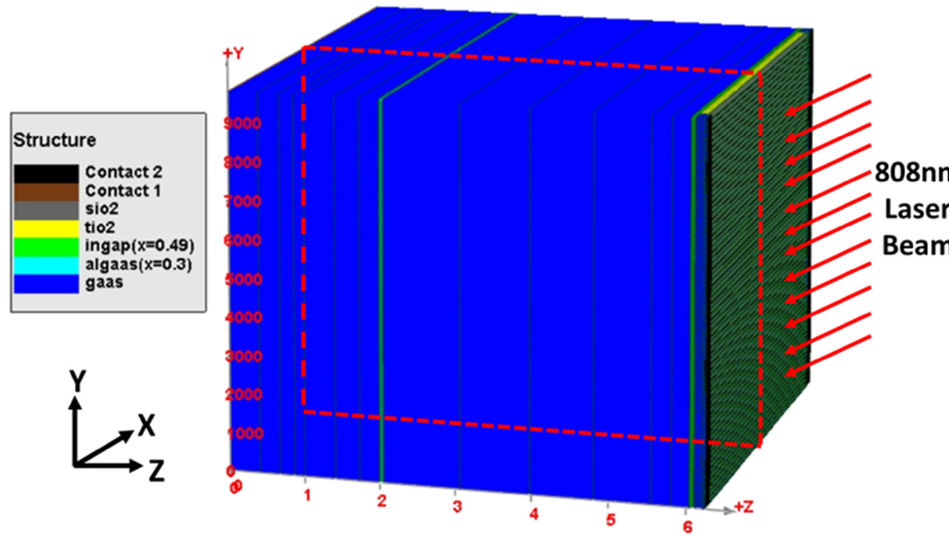
Figure 9. The cross-section of the laser photovoltaic in the YZ Figure 9. The cross − section of the laser photovoltaic in the YZ direction.